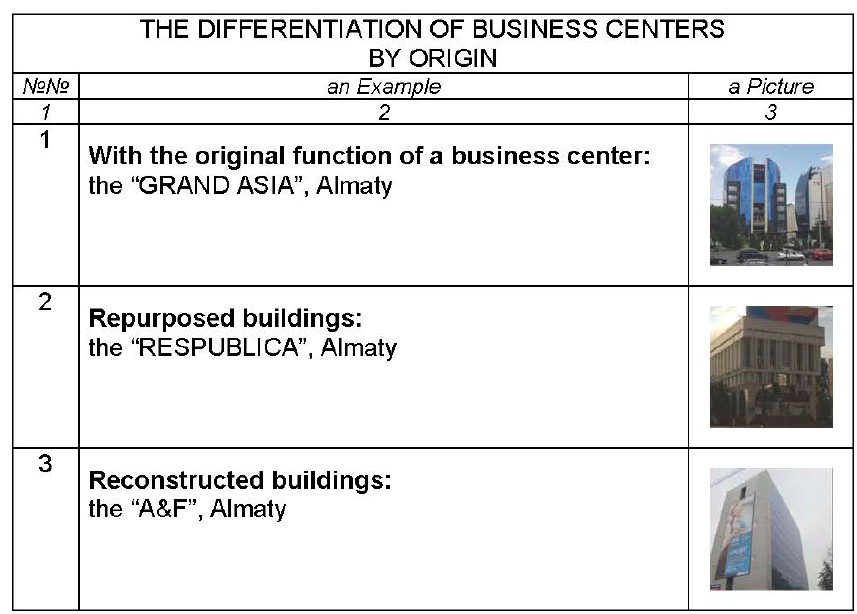
Figure 12. The differentiation of business centers by origin: ( 1 ) the GRAND ASIA, Almaty [118]; ( 2 ) the RESPUBLICA, Almaty [119]; and ( 3 ) the A&F, Almaty [120].